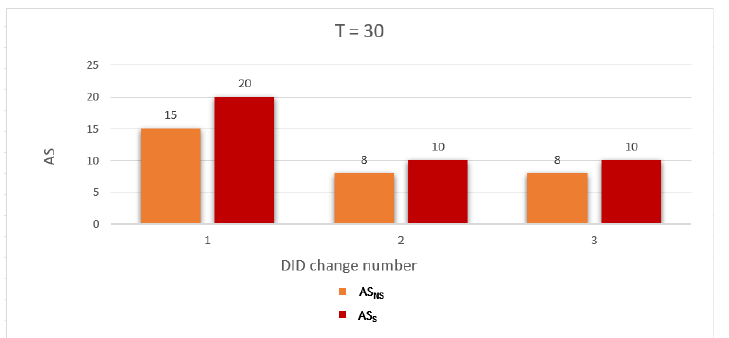
Figure 9. Anonymity of the source node (AS) for each DID change with 20 nodes.